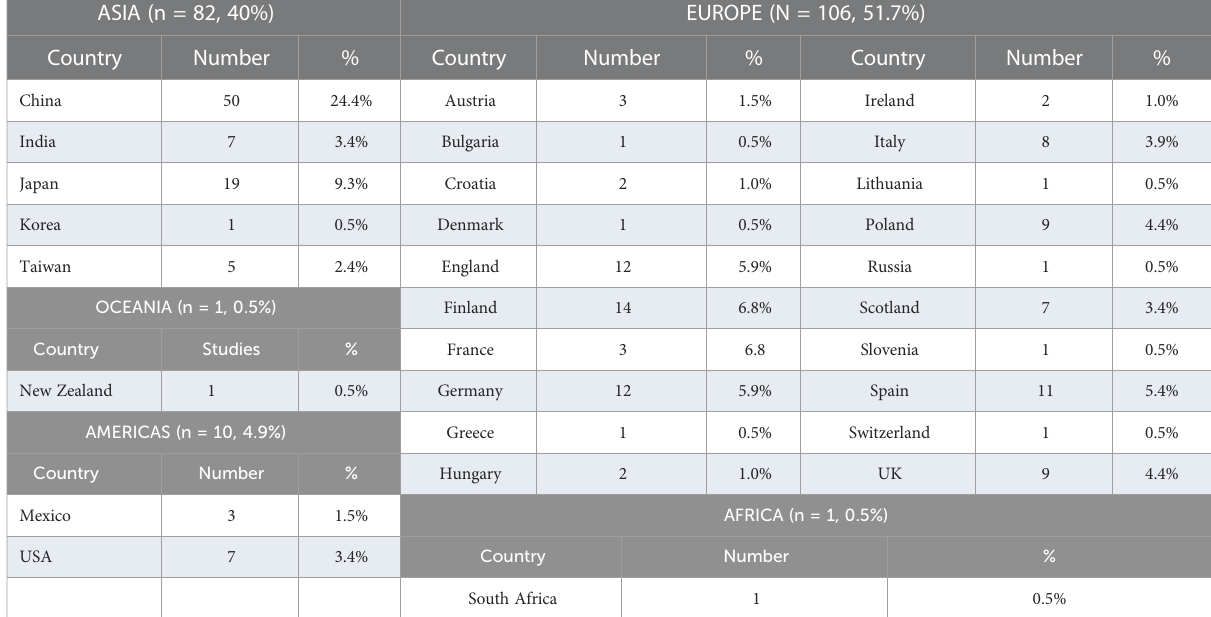
TABLE 3 Included studies by continent with number and